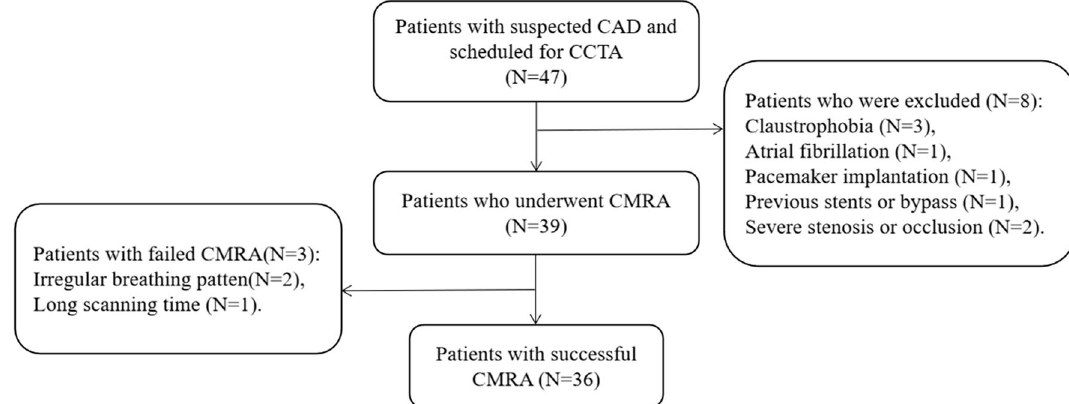
Fig. 1 Flowchart of the study participants. CAD, coronary artery disease; CCTA, coronary CT angiography; CMRA, coronary MR